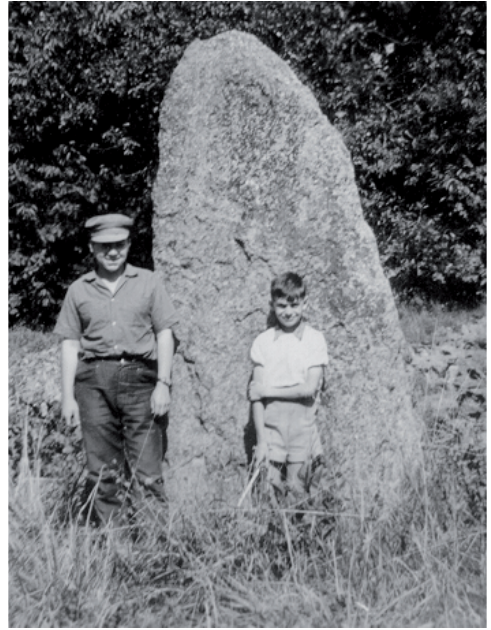
Figure 21. The Métayer menhir in St-Paul-d’Eyjeaux (Haute- Vienne). © J.-L.